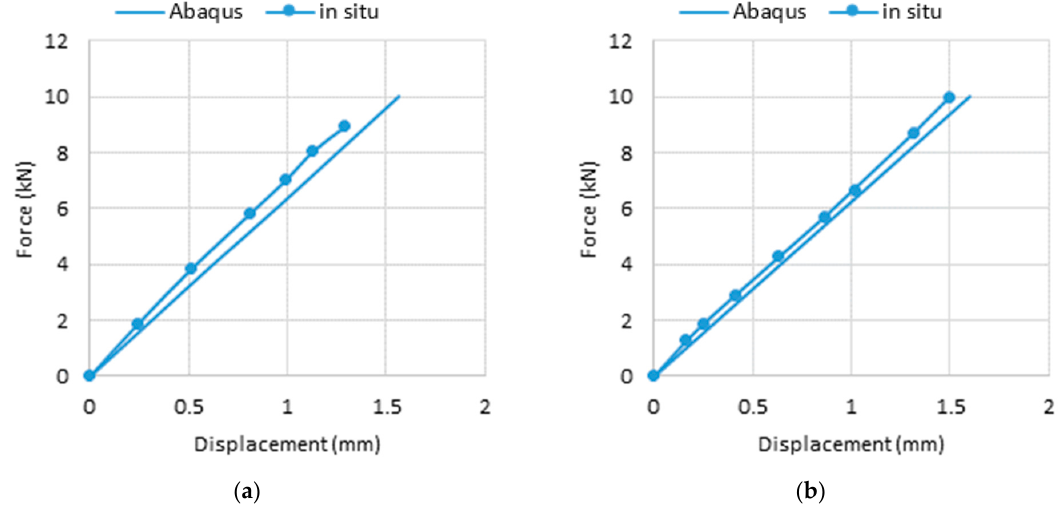
Figure 8. Scheme A measurements and simulation results for ( a ) Series 1 and ( b ) Series 2.